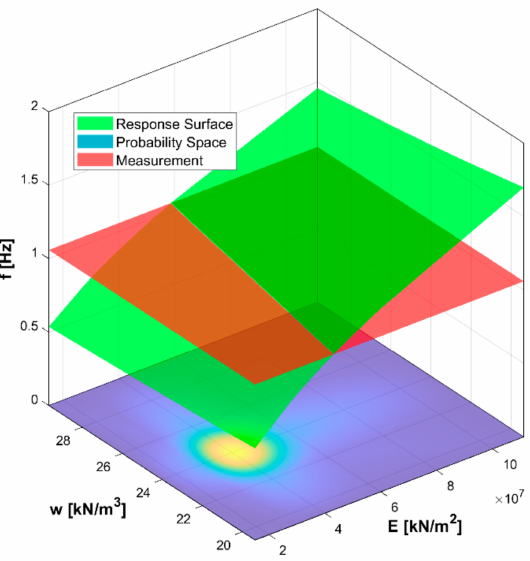
Figure 17. Response surface of the fundamental natural frequency f —concrete water tank.